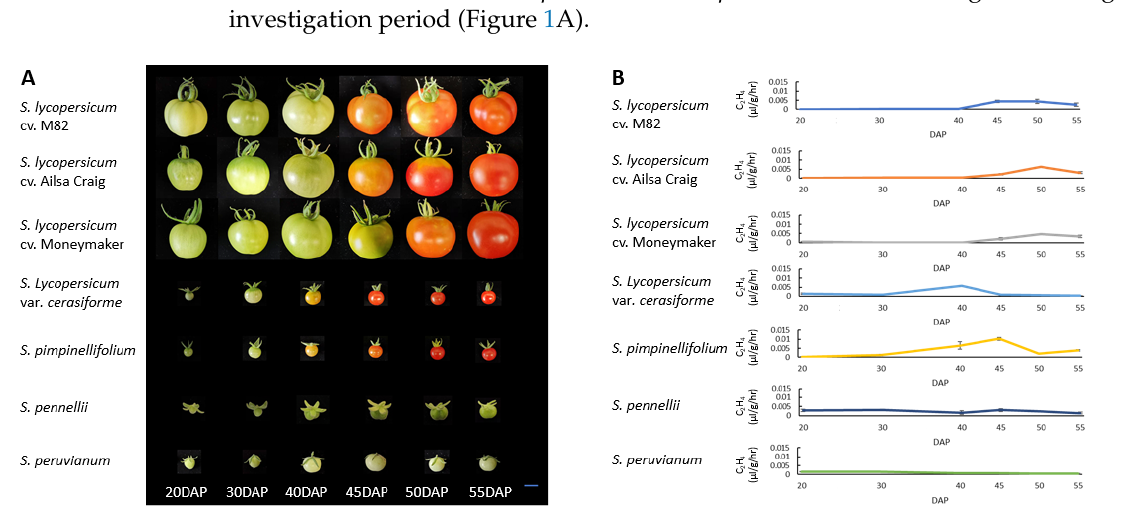
Figure 1. Comparison of fruit ripening and ethylene production among tomato species and cultivars. Changes in skin color ( A ) and quantification of ethylene production during fruit development ( B ). Scale bar = 1 cm. DAP: days after pollination. Fruits were observed from 20 to 55 DAP for each species and cultivar. Error bars in ( B ) represent the standard deviation (SD) of five biological replicates.